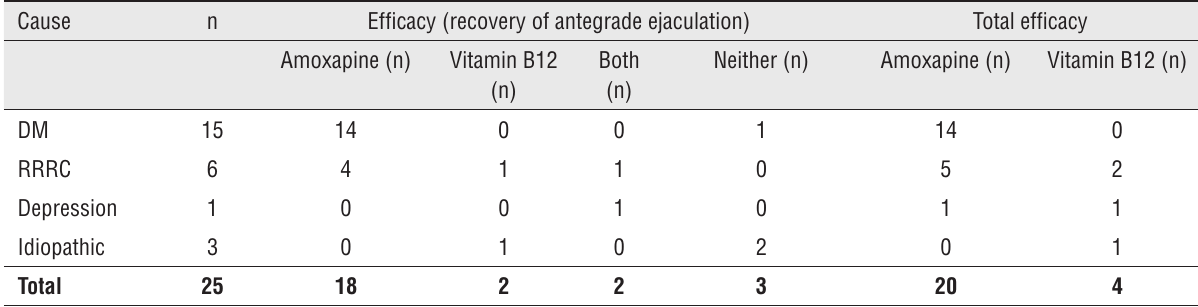
figure 3 - comparison of success rates for amoxapine and vitamin B